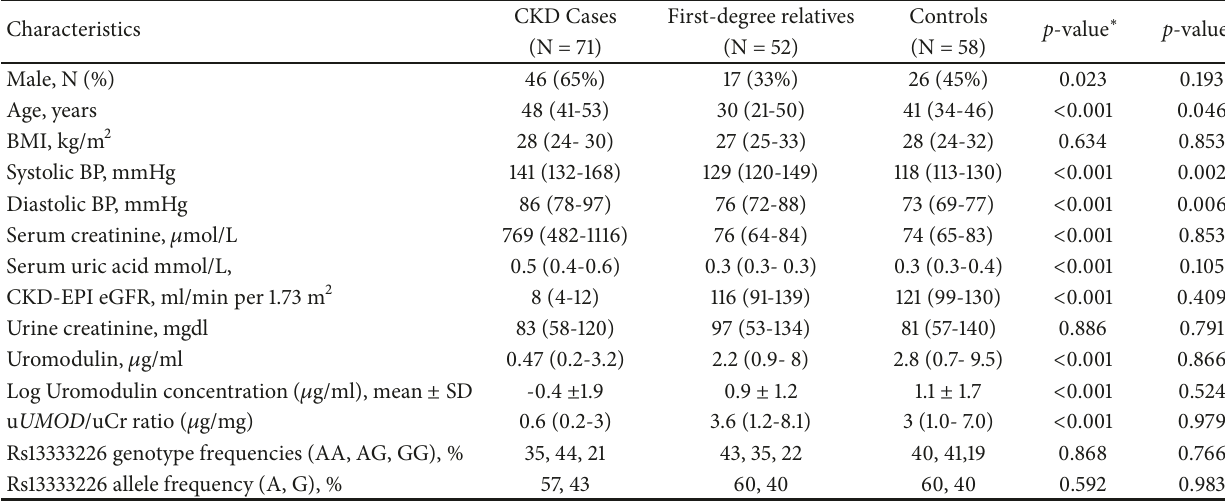
Table 1: Characteristics of the study